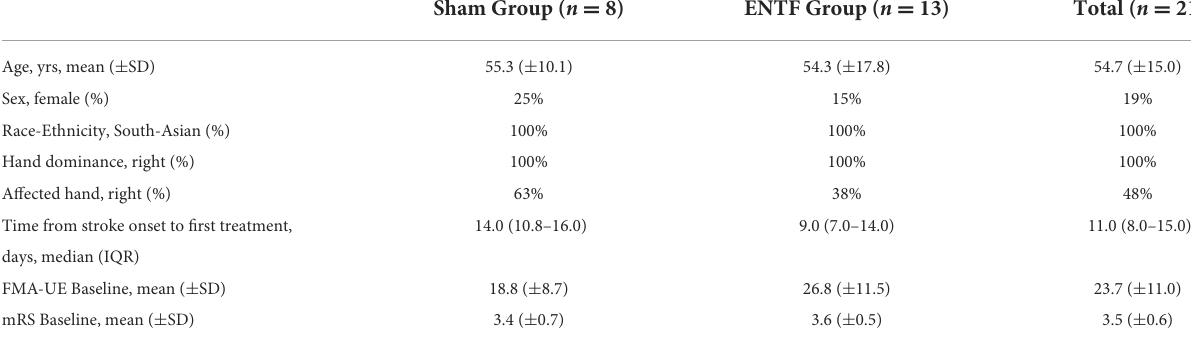
TABLE 1 Participant demographics *